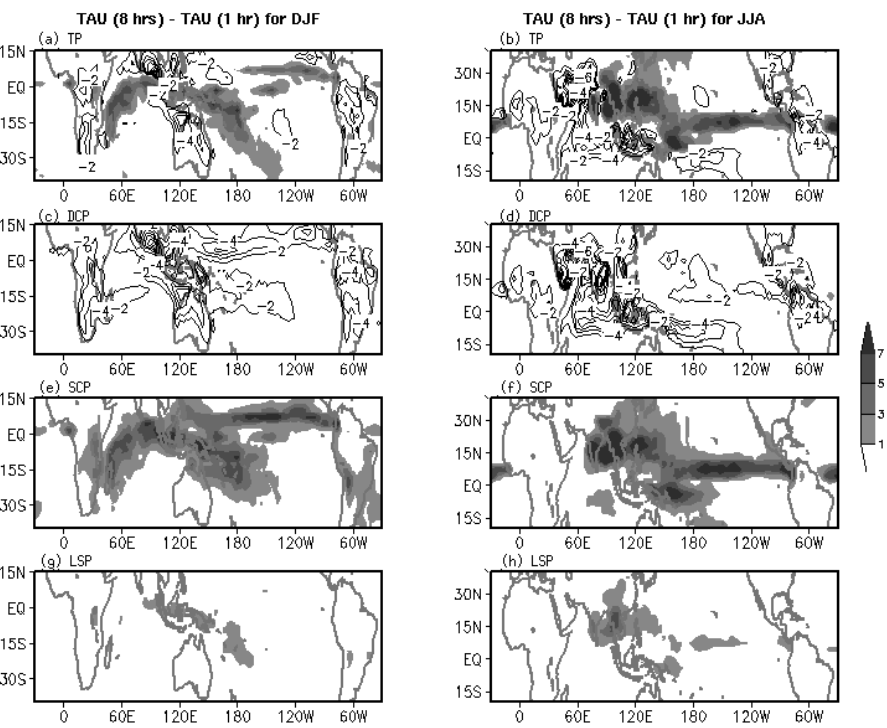
Fig. 23. Difference in the Climatologically mean precipitation (mm/day) between TAU (8h) and TAU (1h). The left panel is for DJF and the right panel for JJA. (a) and (b) Total precipitation, (c) and (d) Convective precipitation, and (e) and (f) Large-scale precipitation. The climatological mean is derived from 10 years (1979 to